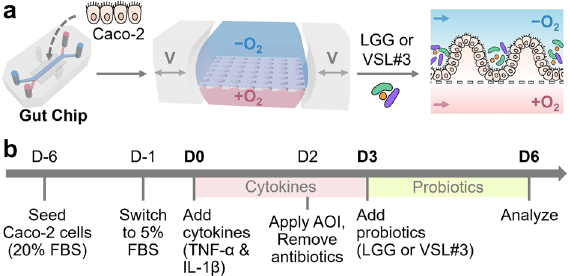
Figure 1. The experimental design of the creation of a Leaky Gut Chip for validating probiotic effects. ( a ) The workflow illustrating the growth of intestinal epithelial Caco-2 cells in a Gut Chip that employs a physiological oxygen gradient and host-probiotics co-cultures with either LGG or VSL#3 cells. The “−O 2 ” and “+O 2 ” mean the absence and the presence of oxygen in the culture medium, respectively. Bidirectional grey arrows in the middle schematic show cyclic mechanical deformations in a Gut Chip. V, cyclic vacuum suctions. A dashed line in the right schematic shows the location of a porous basement membrane in a Gut Chip. Blue and pink arrows display the direction of the culture medium in a Gut Chip. ( b ) An experimental timeline to induce a leaky epithelial barrier and cellular inflammation followed by probiotic amelioration. Epithelial Caco-2 cells are cultured in a Gut Chip under flow and motions for 5–6 days at a high serum condition (20% (v/v) FBS), then switched to a low-serum (5% FBS) culture medium that contains a cytokine cocktail (TNF-α and IL-1β) for 3 days. Probiotic co-cultures were performed after epithelial cells were stabilized to an oxygen gradient and an antibiotic-free condition. During the probiotic co-cultures, cytokine treatment was discontinued. AOI, anoxic–oxic interface; Abx, antibiotics. “D” indicates the day of cultures. We set D0 as the first day of cytokine treatment. D-1 and D-6 denote the pre-culture of Caco-2 cells in a Gut Chip on 1 and 6 days before the cytokine treatment, respectively. The pink and green boxes indicate the period of a cytokine challenge and a probiotic co-culture, respectively.